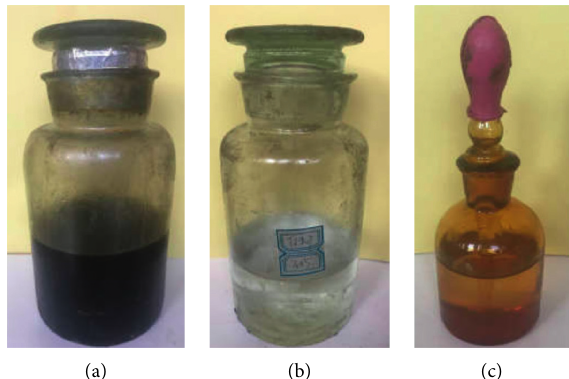
Figure 4: Composition of polyurethane. (a) Polyaryl polymethylene isocyanate WANNATE ® PM-200. (b) Polyether combinations ES305. (c) Catalyst Dabco MixCO2.